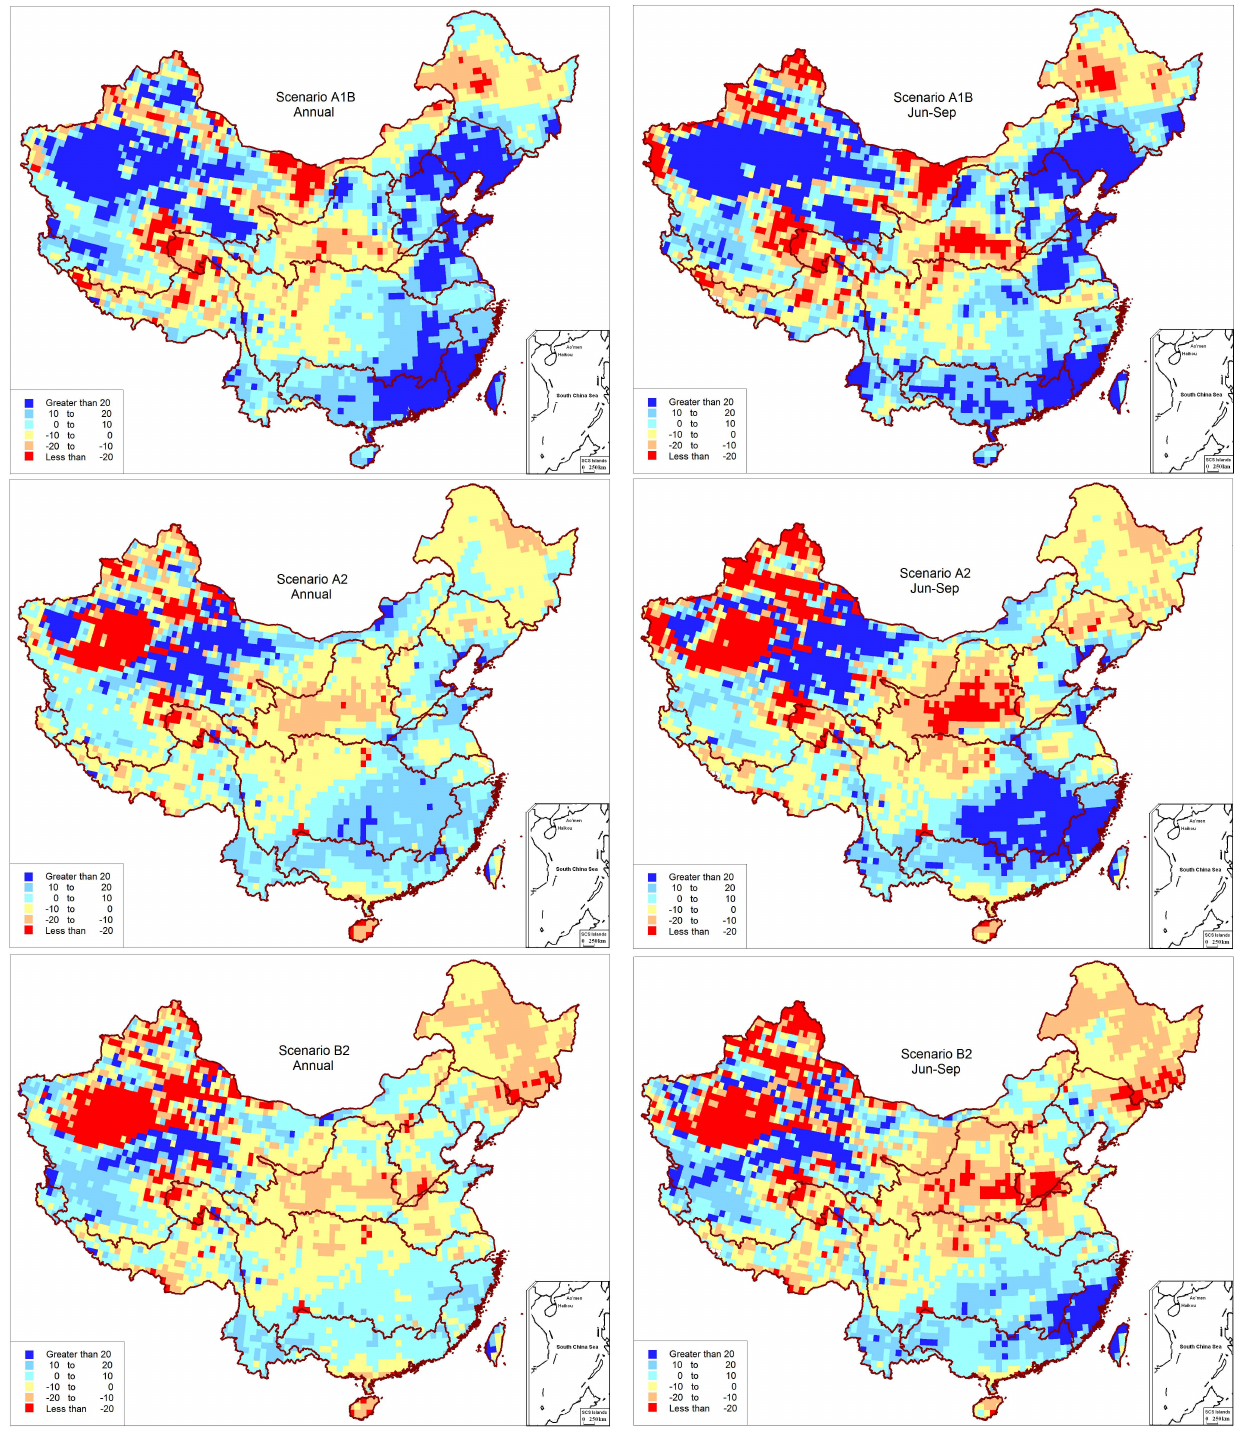
Fig. 8. Distribution of projected average runoff changes, for whole year (annual) and flood season from June to September, in 2021–2050 under A1B, A2 and B2 scenarios (baseline: